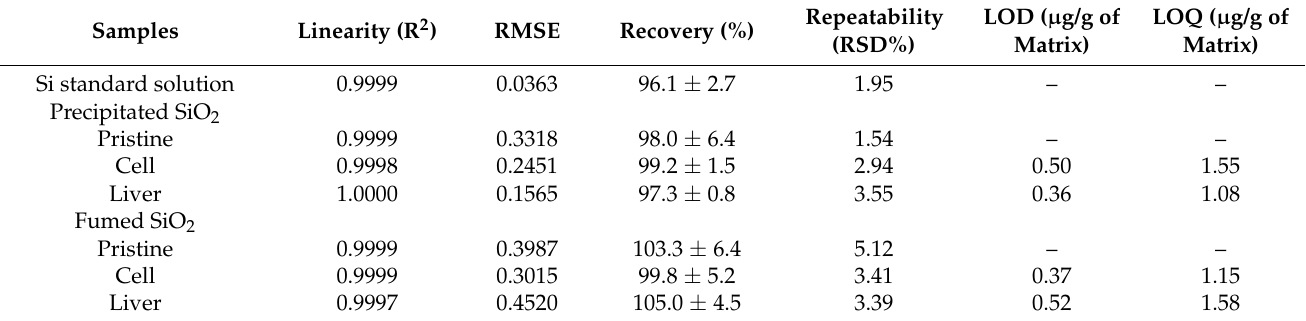
Table 2. Validation parameters of the quantitative analytical method for SiO 2